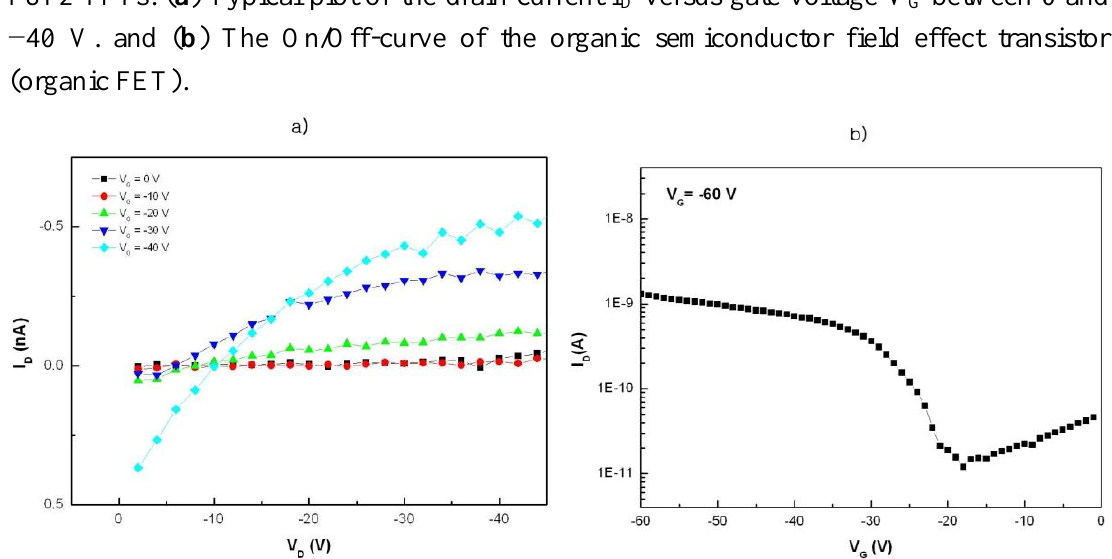
versus gate voltage V for biotinylated D G versus gate voltage V between 0 and D G